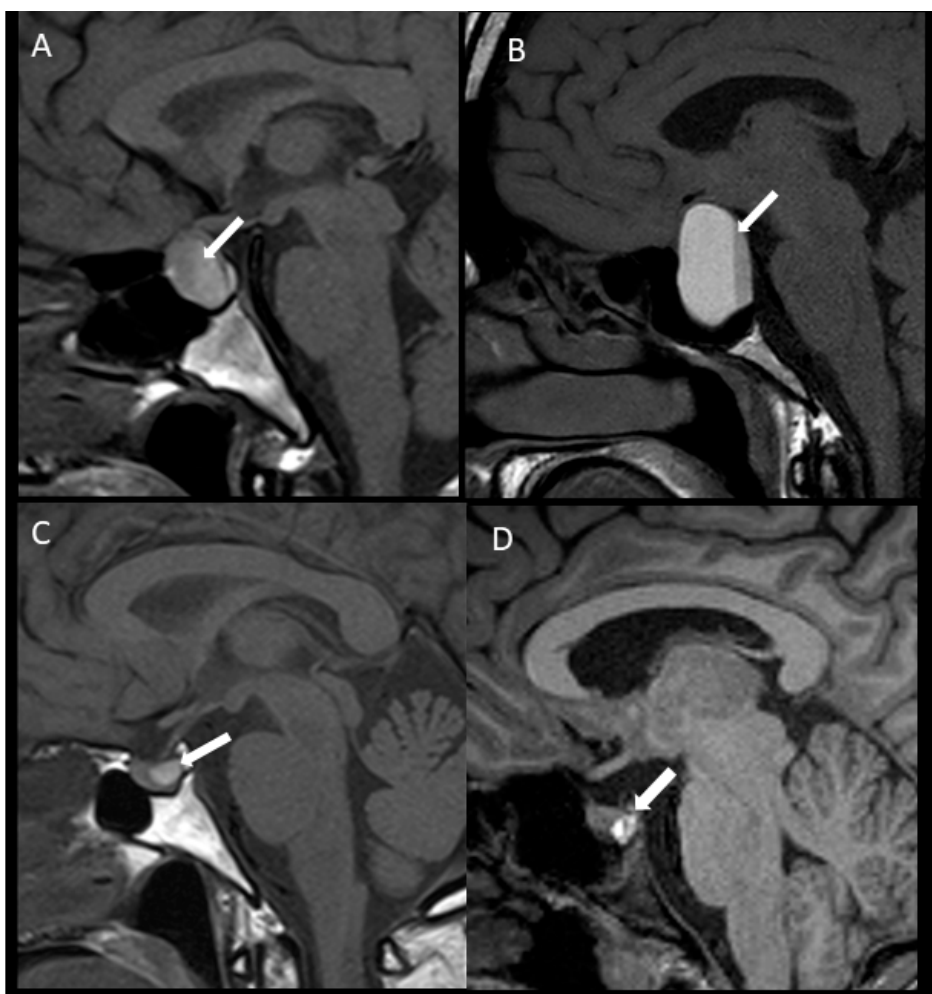
Figure 1. Pituitary apoplexy in macroadenoma (above) and microadenomas (below). Apoplexy in macroadenoma with subclinical presentation ( A ) and with acute clinical presentation ( B ), sagittal unenhanced T1WI, the intrasellar mass showed posterior hyperintensity that forms a level related to acute/subacute bleeding (arrow). Apoplexy in microadenoma with subclinical presentation ( C ) and with acute symptoms ( D ), sagittal unenhanced T1WI showed a microadenoma with hyperintensity related to bleeding (arrow). T1WI: T1-weighted image .